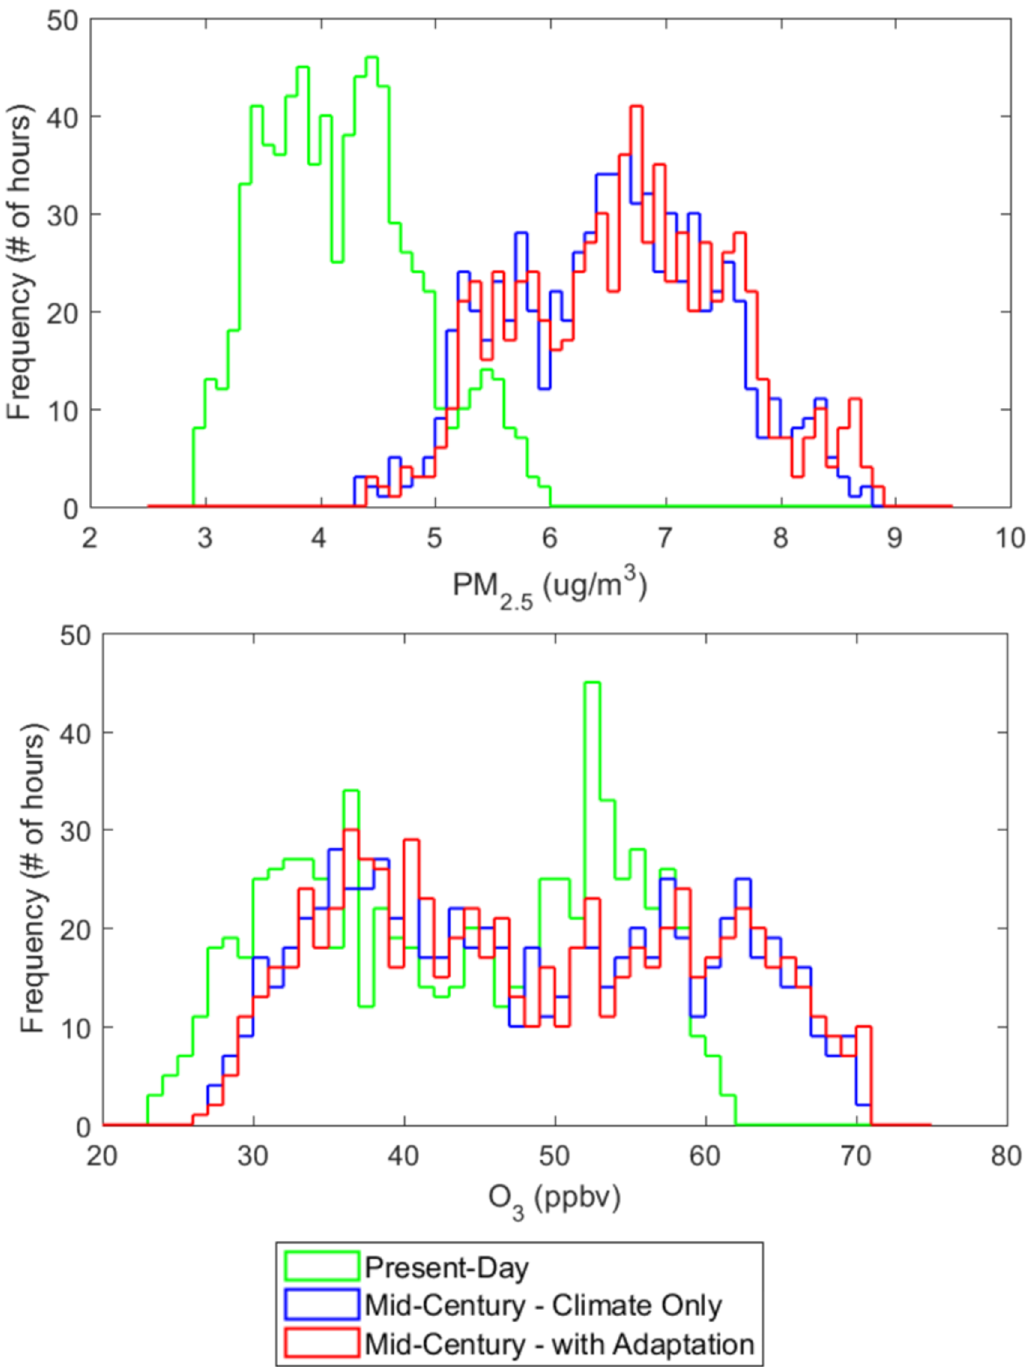
Fig 6. Histograms of ambient air pollutant concentrations. Histograms of regional average hourly concentrations of PM 2.5 (μg/ m 3 ) and O 3 (parts per billion by volume [ppbv]) for July in the present-day (PD) scenario, the warm mid-century climate-only (MCCO) scenario, and the warm mid-century adaptation (MCA) scenario. For PM 2.5 concentrations: PD mean: 4.19 μg/m 3 ; minimum: 2.91; maximum: 5.98. MCCO mean: 6.57 μ g/m 3 ; minimum: 4.37; maximum: 8.75. MCA mean: 6.67 μ g/m 3 ; minimum: 4.48; maximum: 8.87. For O 3 concentrations: PD mean: 43.4 ppbv; minimum: 23.6; maximum: 61.7. MCCO mean: 48.0 ppbv; minimum: 26.4; maximum: 70.2. MCA mean: 48.4 ppbv; minimum: 26.6; maximum: 70.9.